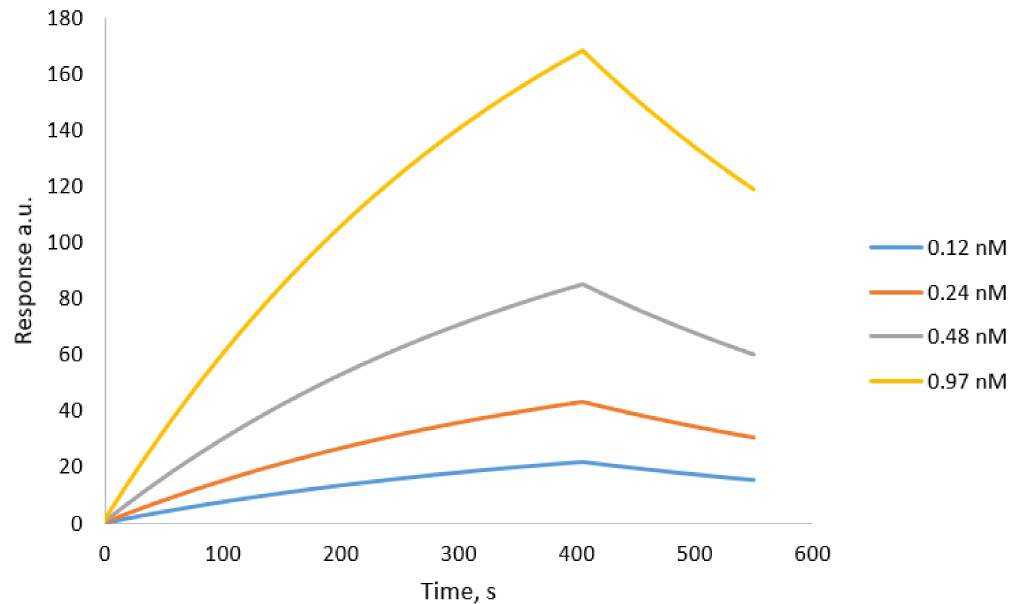
Figure 4. SPR sensorgrams for native trypsin-specific nanoMIPs. They were injected onto specific trypsin-coated sensor surface. Solutions of NPs were injected at concentrations ranging from 0.12 nM to 0.97 nM. SPR tests were performed in PBS buffer pH 7.4 at 25 ◦ C.